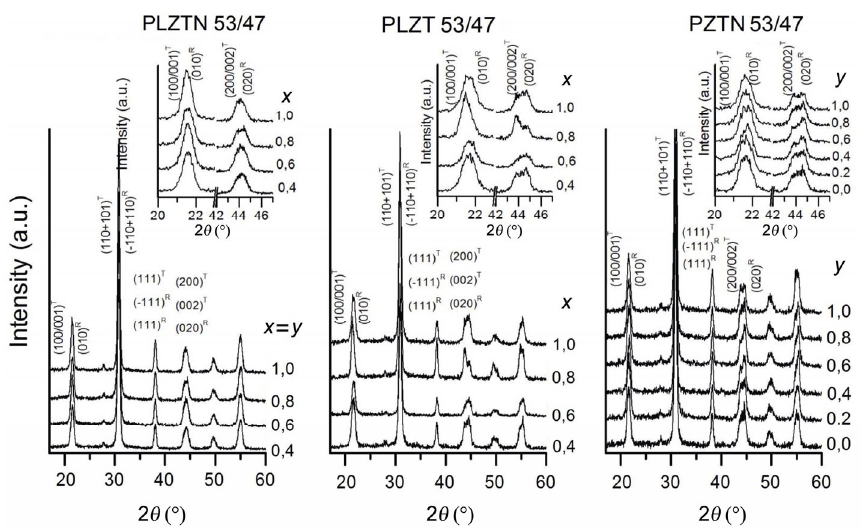
Fig. 1 XRD patterns of PLZTN, PLZT, and PZTN samples at room temperature.